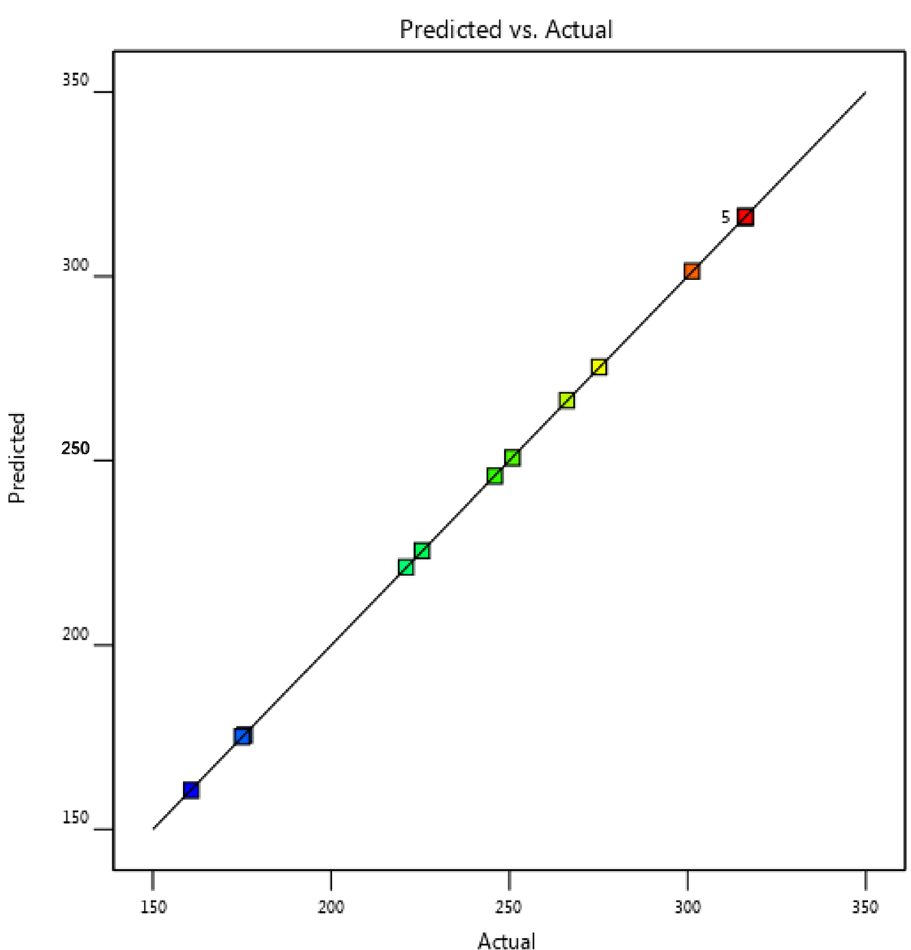
Fig. 1 Parity plots showing dis- tribution of experimental and predicted values of keratinase